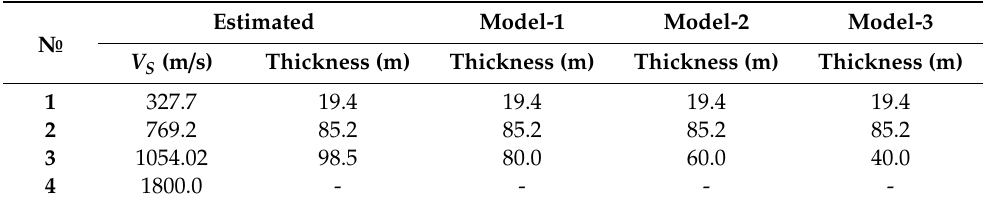
Table 5. The parameters for sensitivity analysis (UB33).